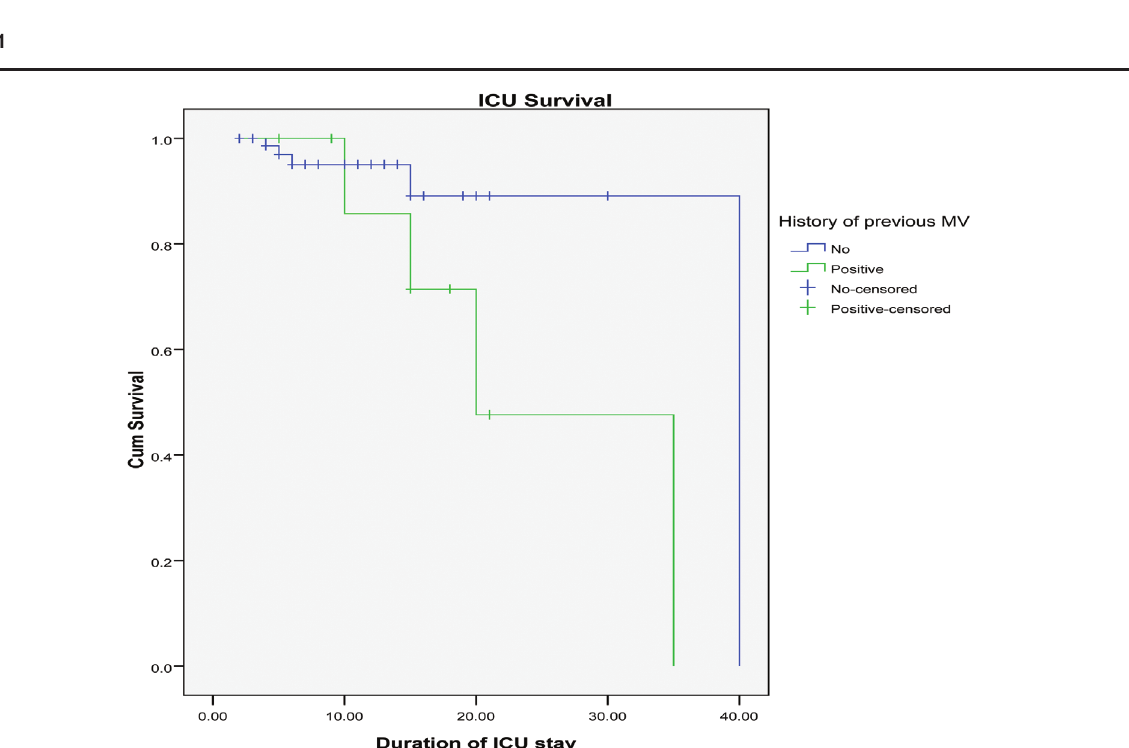
Kaplan – Meier survival curves of survival in interstitial lung disease patients in ICU. Blue line ( n = 82) denotes patients that were not previously mechanical ventilation (MV) (including five patients that died). Green line ( n = 9) denotes patients with history of previous MV (including four patients who died). Global log-rank test ( P >